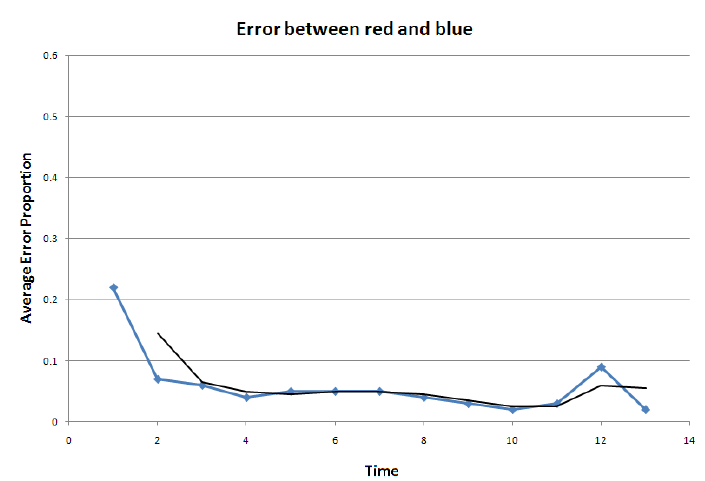
Figure 17. Error between the red and blue